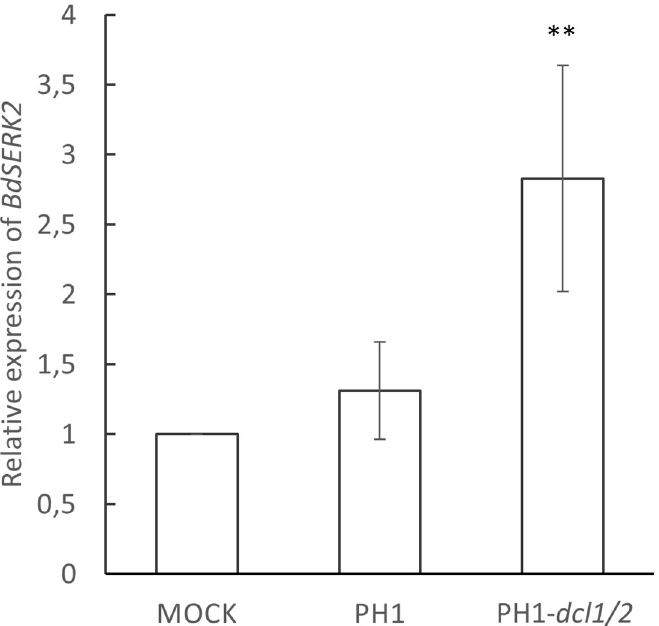
Fig 5. Relative expression of BdSERK2 in response to inoculation of Brachypodium distachyon leaves with Fusarium graminearum . Relative expression of BdSERK2 in detached Bd21-3 leaves at 4 dpi with PH1 vs. PH1 -dcl1/2 . The gene expression was first normalized against the reference gene BdUBI4 and subsequently against the Δ ct of the mock treated control. Values and error bars represent the mean ± SE of three independent biological replicates. (Student‘s t-test, paired, one sided, �� P < 0,01).